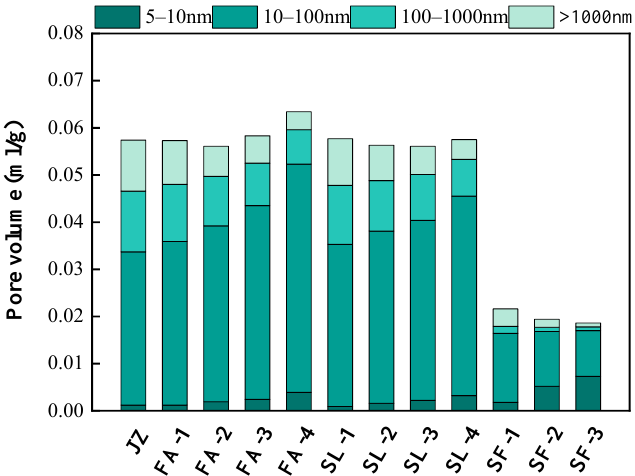
Figure 10. Pore volume distribution of cement mortar.